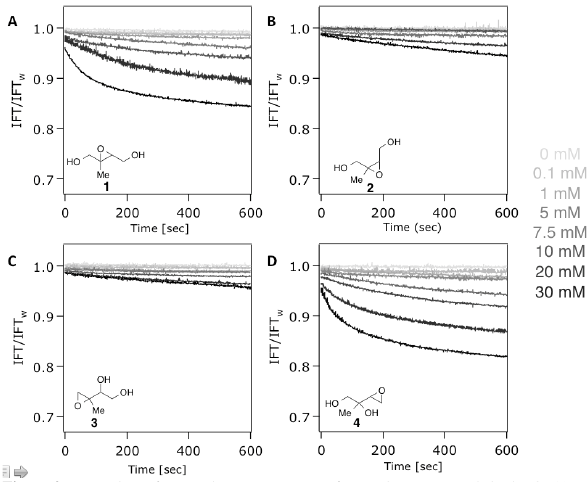
Figure 3. Dynamic surface tension measurements for IEPOX com- 356 pounds in 1M (NH 4 ) 2 SO 4 . (a) trans- β -IEPOX (1) (b) cis- β